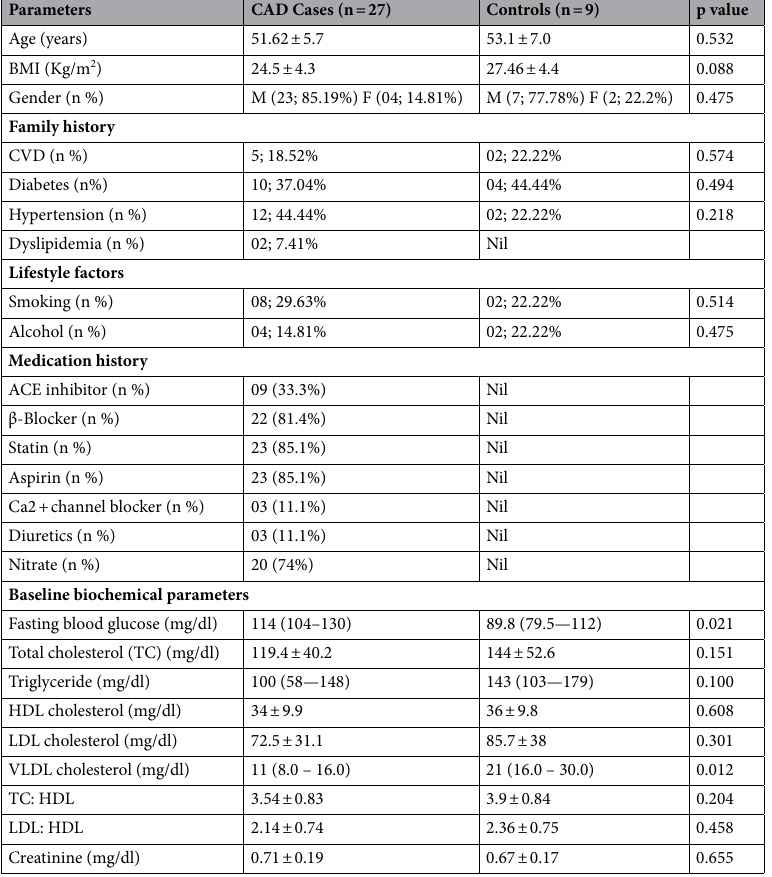
Table 2. Demographic, anthropometric, medication history and biochemical variables in CAD cases and healthy controls: Based on successful ECFCs culture in vitro. Data expressed as mean ± standard deviation for normally distributed data and as median and interquartile range (IQR) for non-normally distributed data. Categorical variables were represented in percentage. Unpaired t-test and Mann Whitney test U was performed for normally and non-normally distributed data and Chi2 test for categorical variables respectively. p values ≤ 0.05 was considered statistically